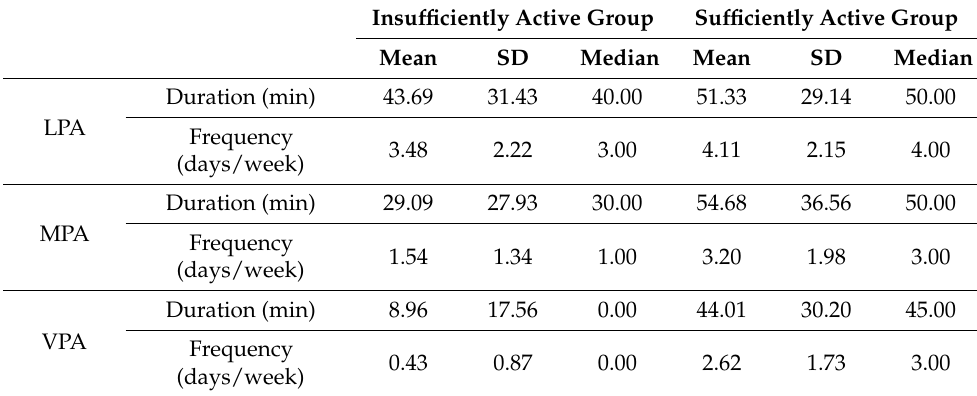
Table 2. Insufficiently active group vs. sufficiently active group during